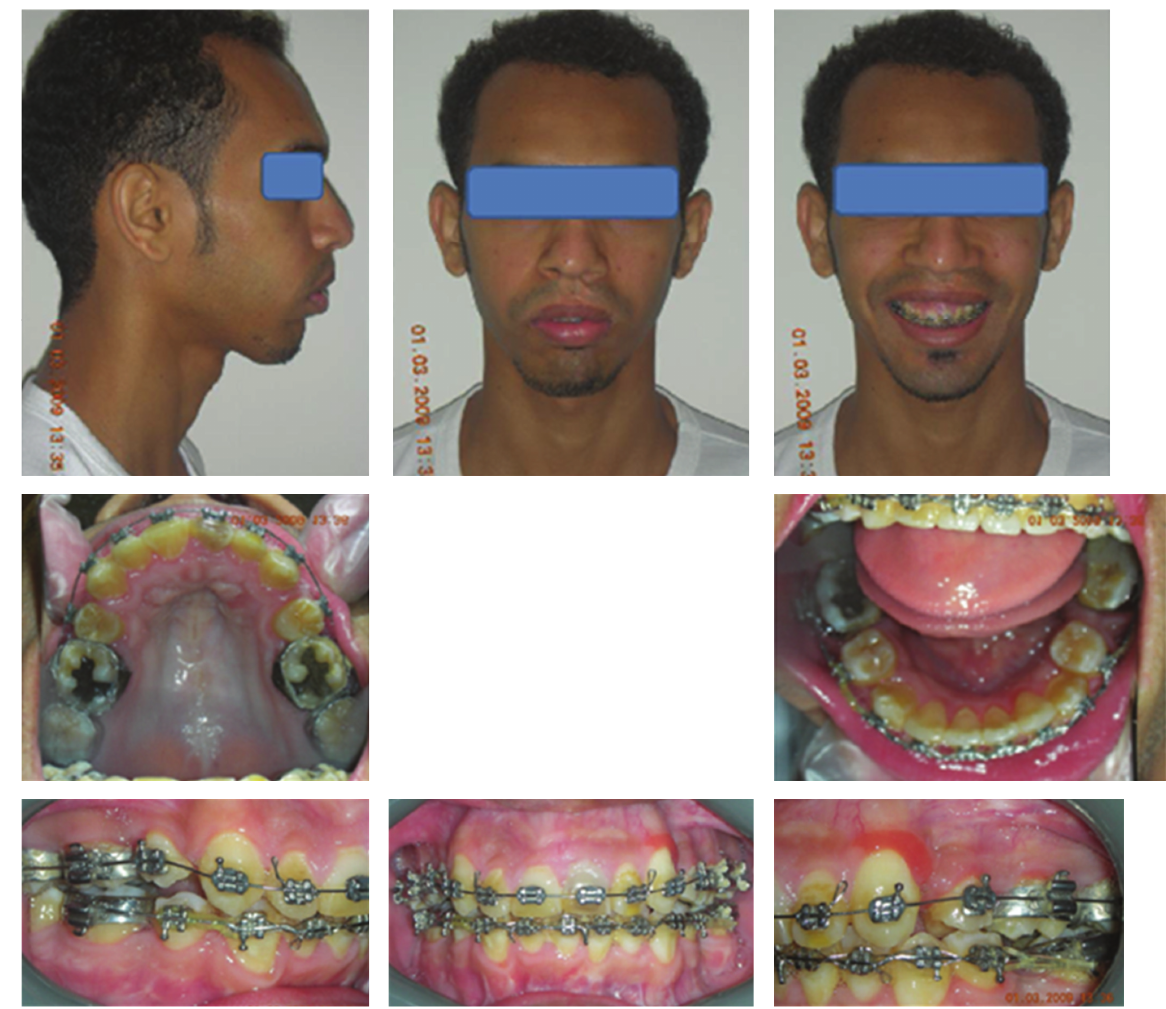
Figure 3: Postsurgical extraoral and intraoral